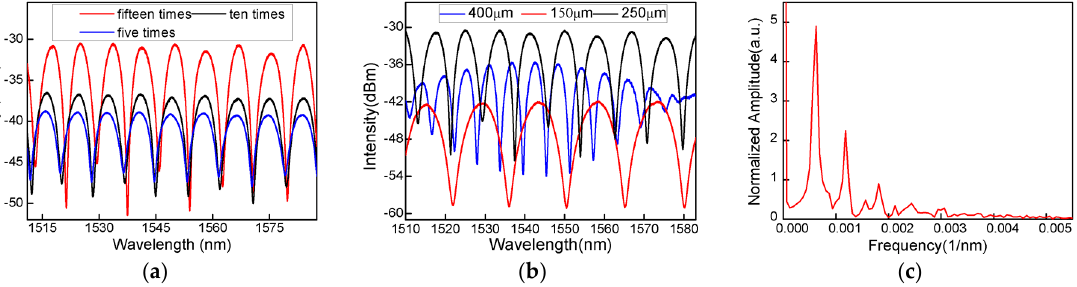
Figure 2. ( a ) Spectrogram in HCF of different discharge times; ( b ) spectrogram at different lengths; ( c ) spatial frequency.